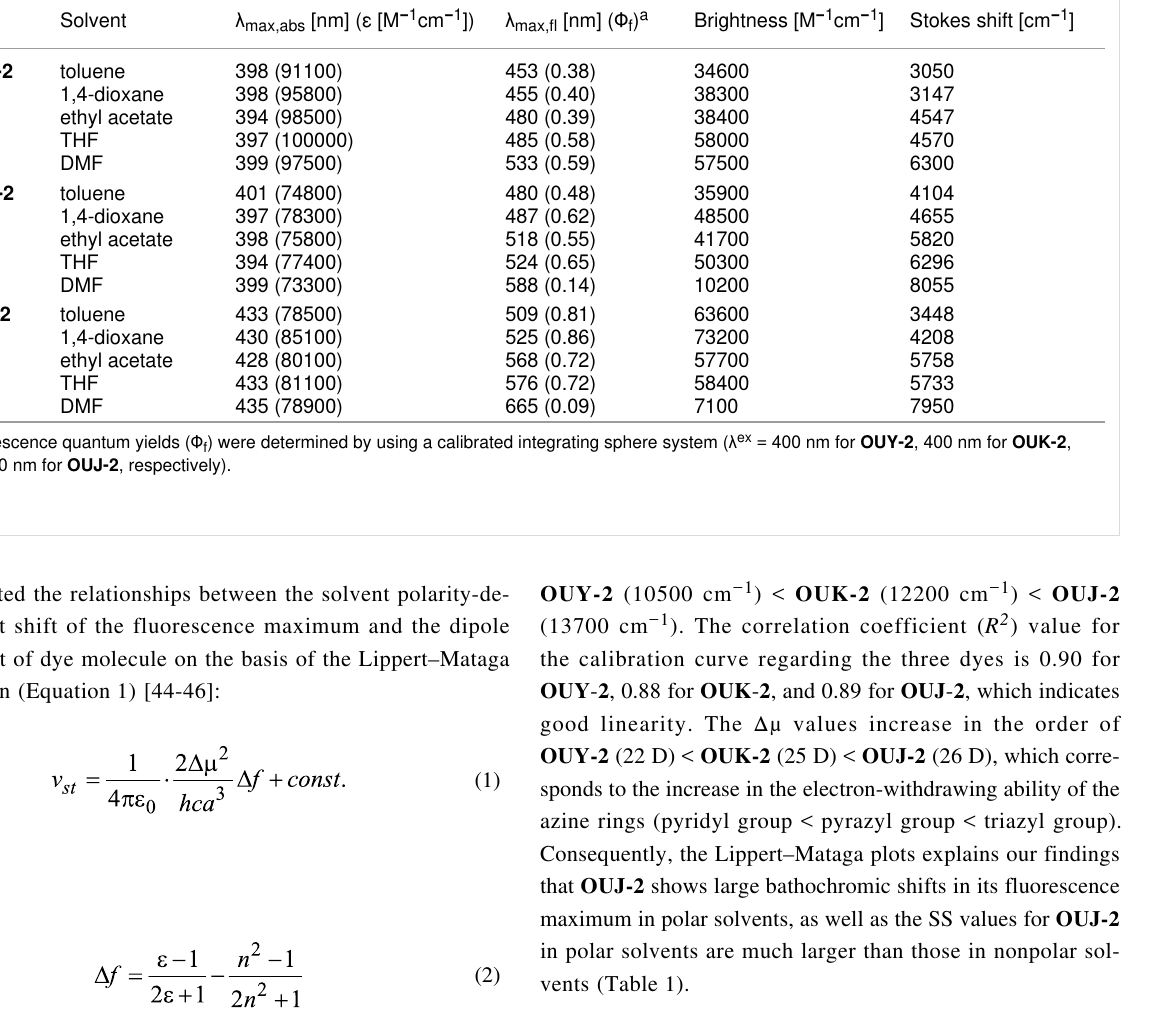
Table 1: Optical data of OUY-2 , OUK-2 and OUJ-2 in various solvents.